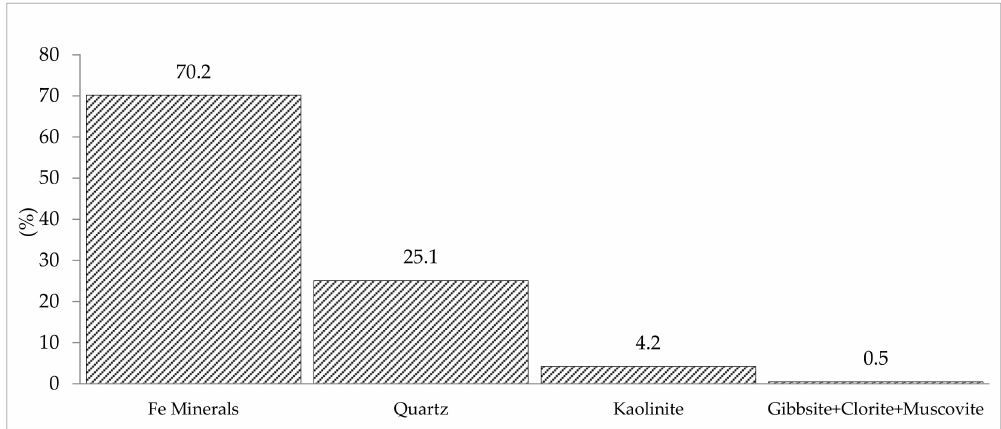
Figure 5. Typical mineralogical composition of a slimes sample from the industrial plant studied.